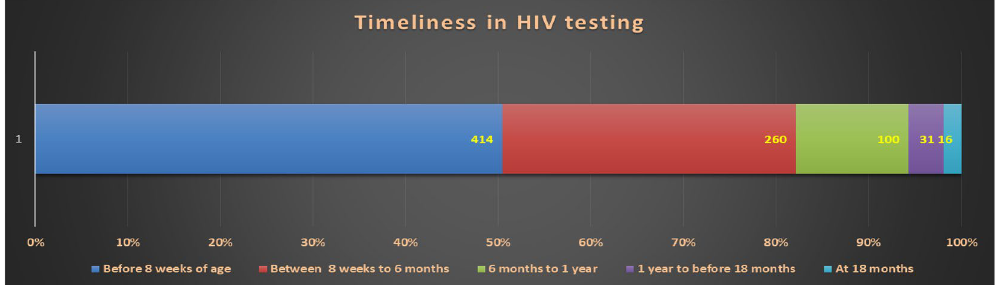
Figure 3. Timeliness of first sample for HIV testing among HIV exposed infants (n =